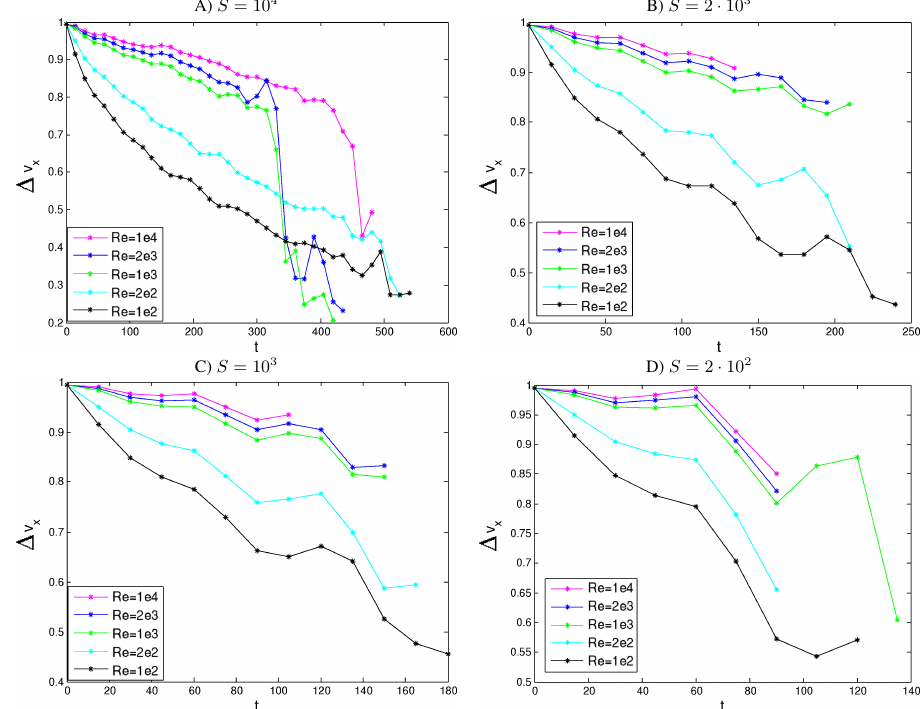
Fig. 5. Evolution of the difference ∆ V x between the maximum (fast solar wind) and minimum (slow solar wind) in the profile of the average vertical velocity (normalized to the asymptotic speed u 0 ) max z ( < u x ( z ) > x ) . Several runs are shown starting from the same initial force- free reversed field equilibrium, each panel corresponds to a different resistivity: A) S = 10 4 , B) S = 2 · 10 3 , C) S = 10 3 and D) S = 2 · 10 2 . In each panel 5 viscosities are shown, corresponding in order from the top curve to the bottom curve to R v = 10 4 , R v = 2 · 10 3 , R v = 10 3 , R v = 2 · 10 2 , R v = 10 2 . Note that in the legends, the viscosity is reported directly rather than the Reynolds number: in our normalized units they are simply one the reciprocal of the other.